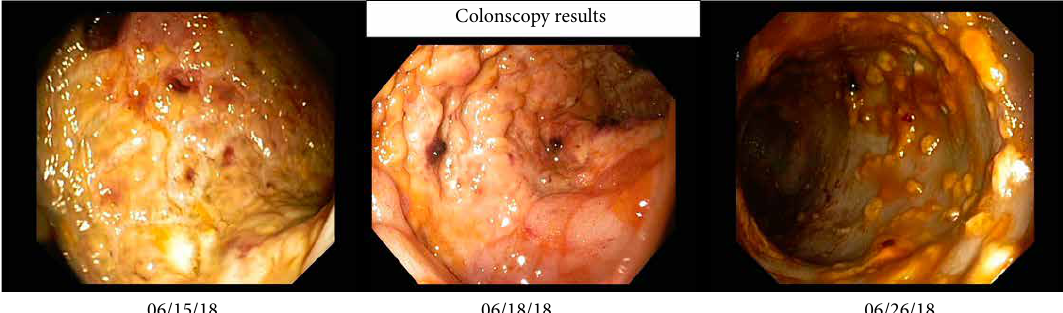
Figure 1: Representative colonoscopy findings in the course. Left: left-sided ischemic colitis; middle: recovery of colitis; right: severe progression of colitis with additional Clostridium difficile